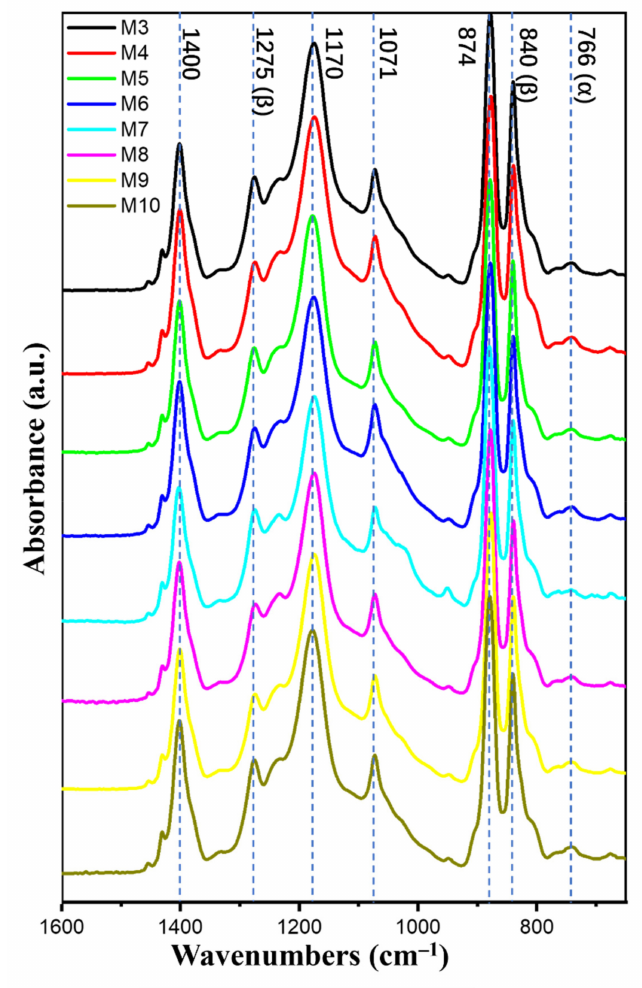
Figure 5. FTIR spectra of all PVDF nanofibrous membranes